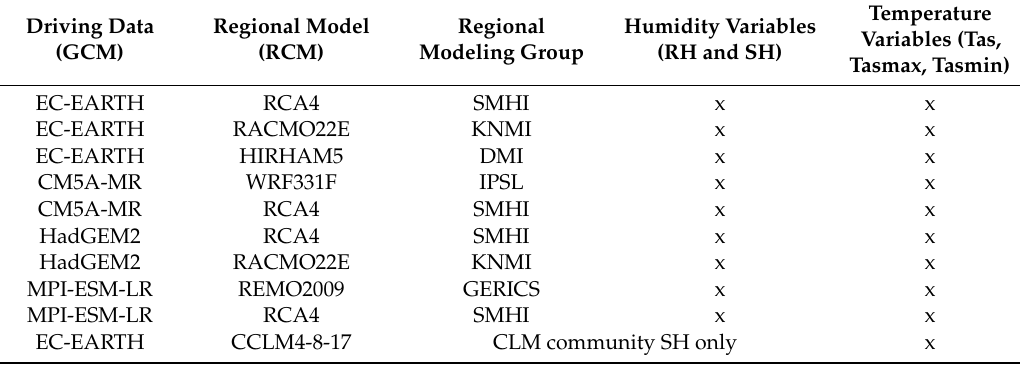
Table 1. Regional climate models and model combinations and their respective simulated variables which were investigated in this research (‘x’ means this variable was investigated). Legend: GCM, global circulation model; RCM, regional climate model; RH, relative humidity; SH, specific humidity; Tas, surface temperature at 2 m height; Tasmax, maximum surface temperature at 2 m height; Tasmin, minimum surface temperature at 2 m